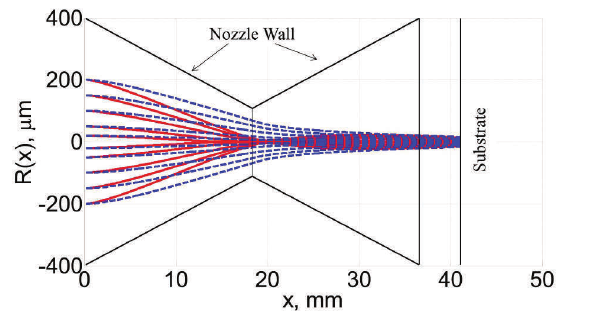
Figure 5. Trajectories of silver aerosol particles with Stokes force and Saffman force applied with McLaugh- lin correction (blue lines) and Dandy-Dwyer correction (red